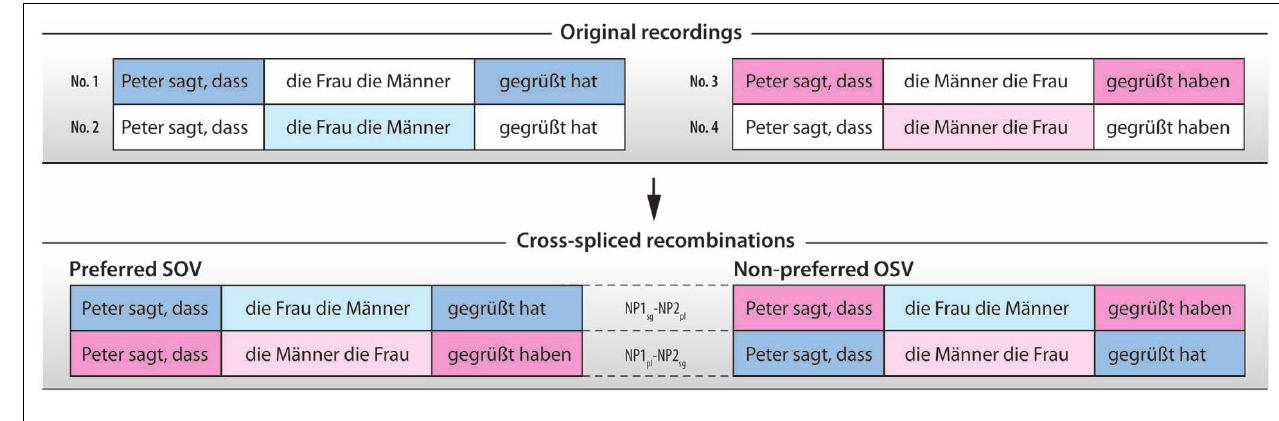
men greeted has . Literal translation of sentence on the right (highlighted in orange): Peter says, that the men the woman greeted have